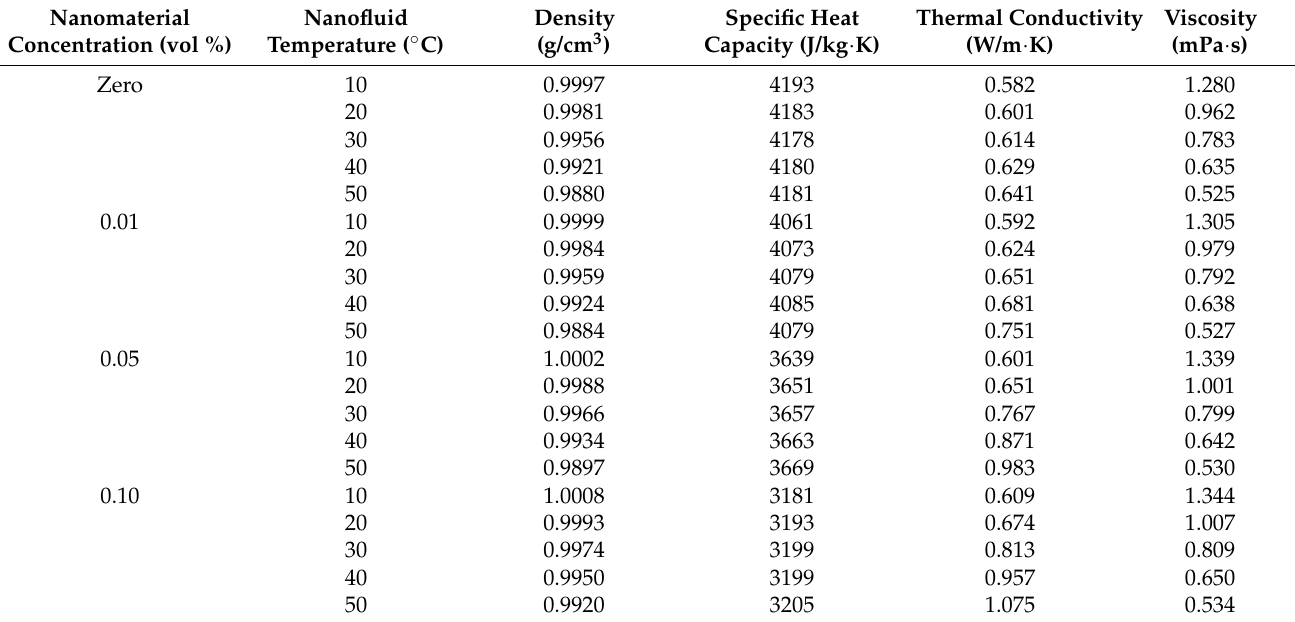
Table 3. Measured thermophysical properties of the base fluid and as-prepared nanofluids.